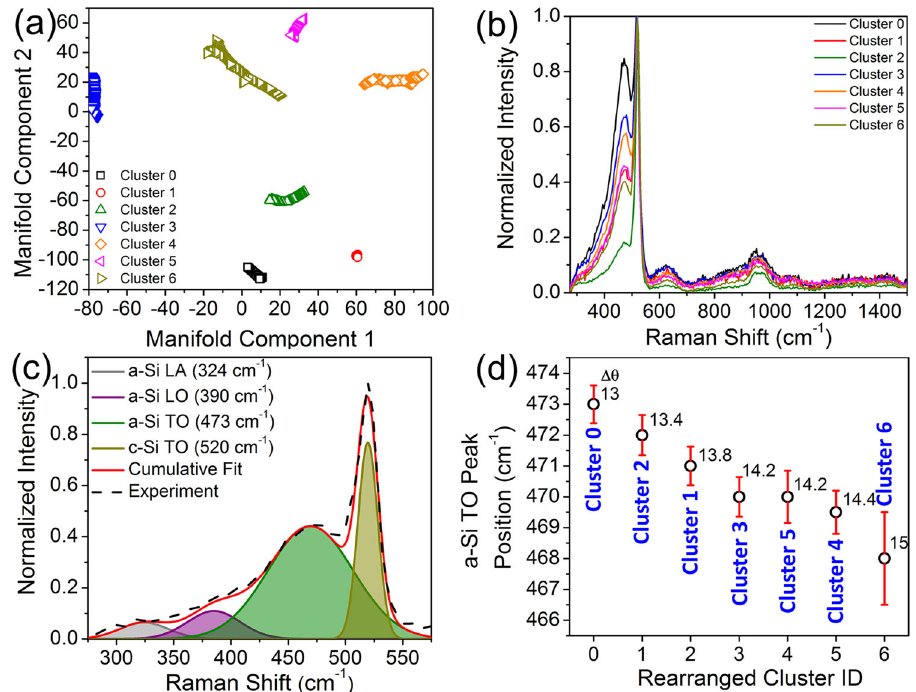
Fig. 3 The parent manifold layout, mean TERS spectra and transverse optical mode peak position via Graph-Bootstrapping algorithm. a The parent manifold layout via the Graph-Bootstrapping method (see details in “ Method ” section) colored by the cluster labels. b The mean tip-enhanced Raman spectroscopy (TERS) spectrum for each cluster (spectrum normalized against the c-Si transverse optical or TO mode at 520 cm − 1 ). c Peak deconvolution of the silicon TO modes, longitudinal optical (LO) mode and longitudinal acoustic (LA) mode. d The TO-band center arranged in declining order. The error bar stands for the Gaussian fi tting deviation of the peak center. Δθ is de fi ned as the deviation of the Si – Si bond angle in the a-Si random network from that of the single-crystal Si